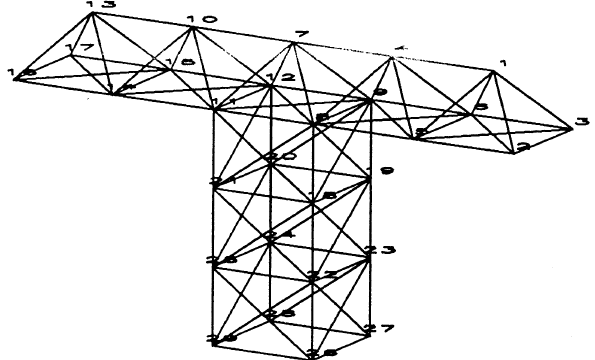
Fig. 3. Topological modifications of truss structure.